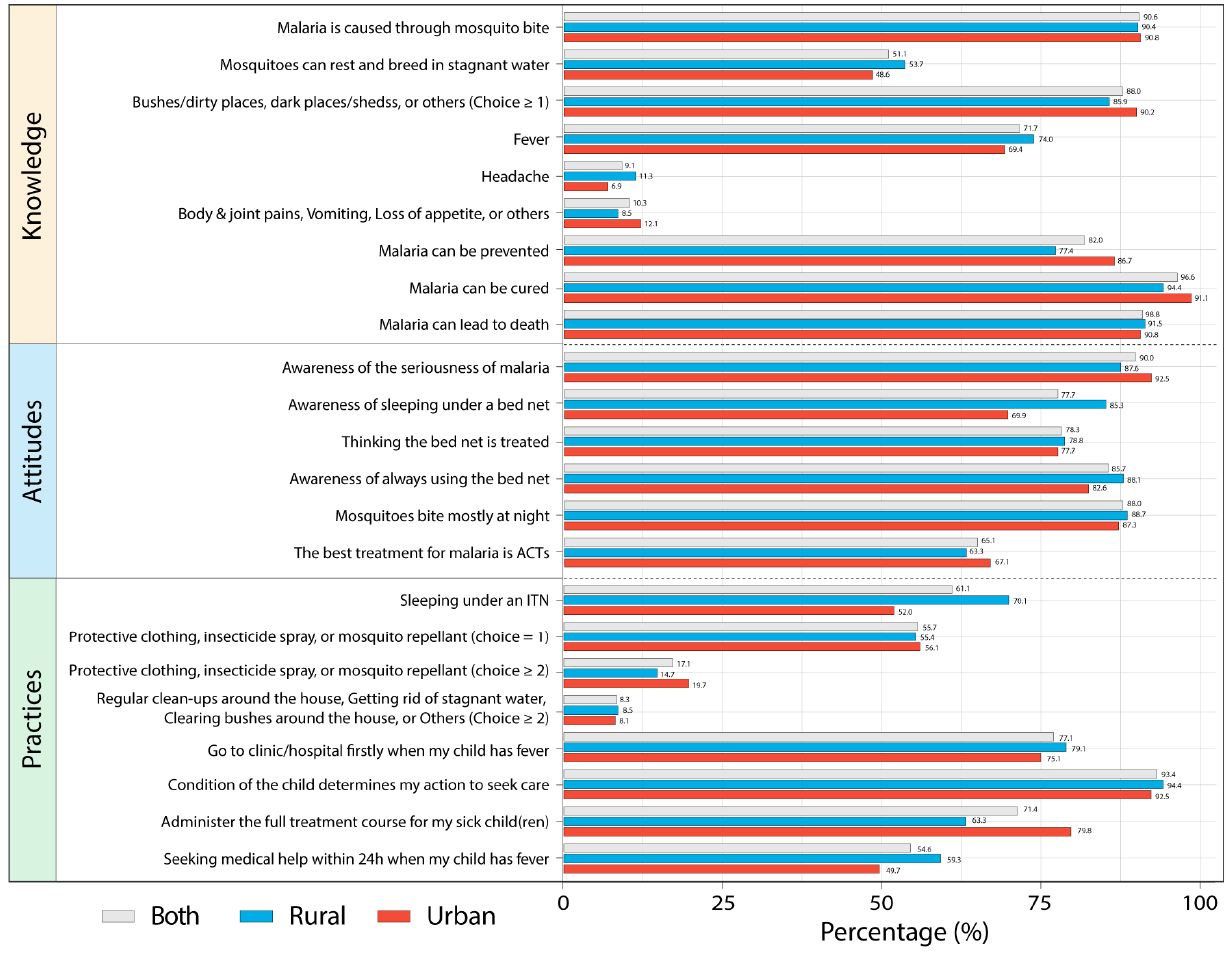
Figure 3. Correct response rates for questions in sections: Knowledge, Attitudes, and Practices. Each item scores 1, except for, “Sleeping under an ITN” in section Practices scoring 2, which were evaluated by the scoring system described in Supplementary file